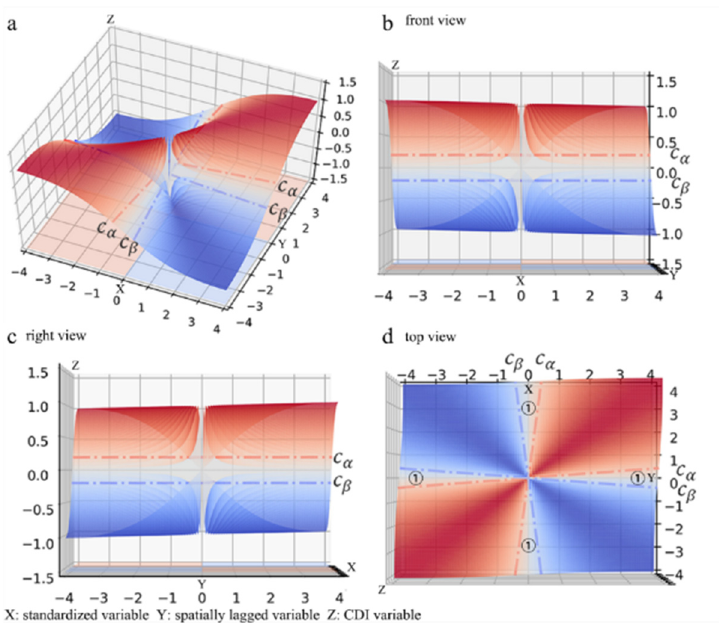
Figure 2. Images of the CDI function. ( a ) Overview; ( b ) Front view; ( c ) Right view; ( d ) Top view.